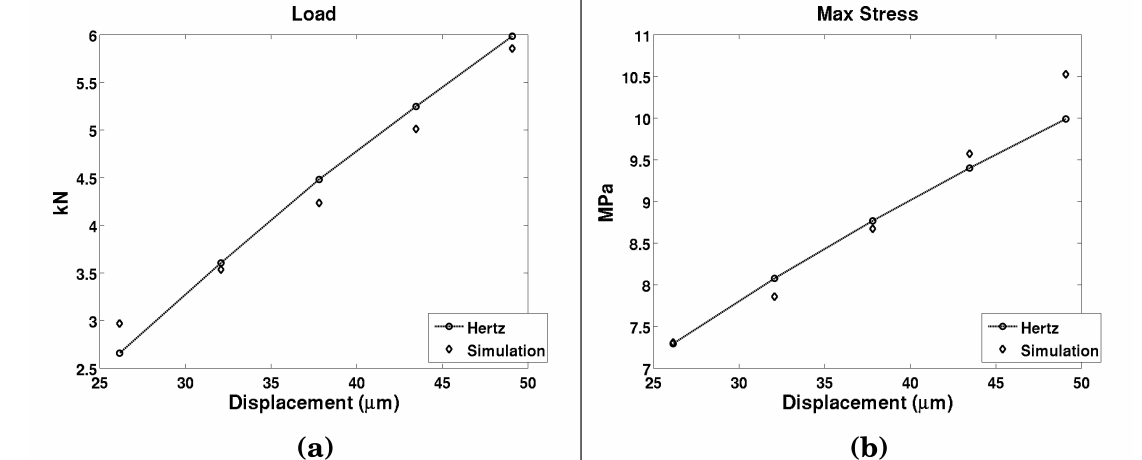
Figure 3. Comparison of Hertz and numerical solid modeling, for both ( a ) the numerically integrated total load, and ( b ) the maximum stress, calculated as a function for a given displacement δ .